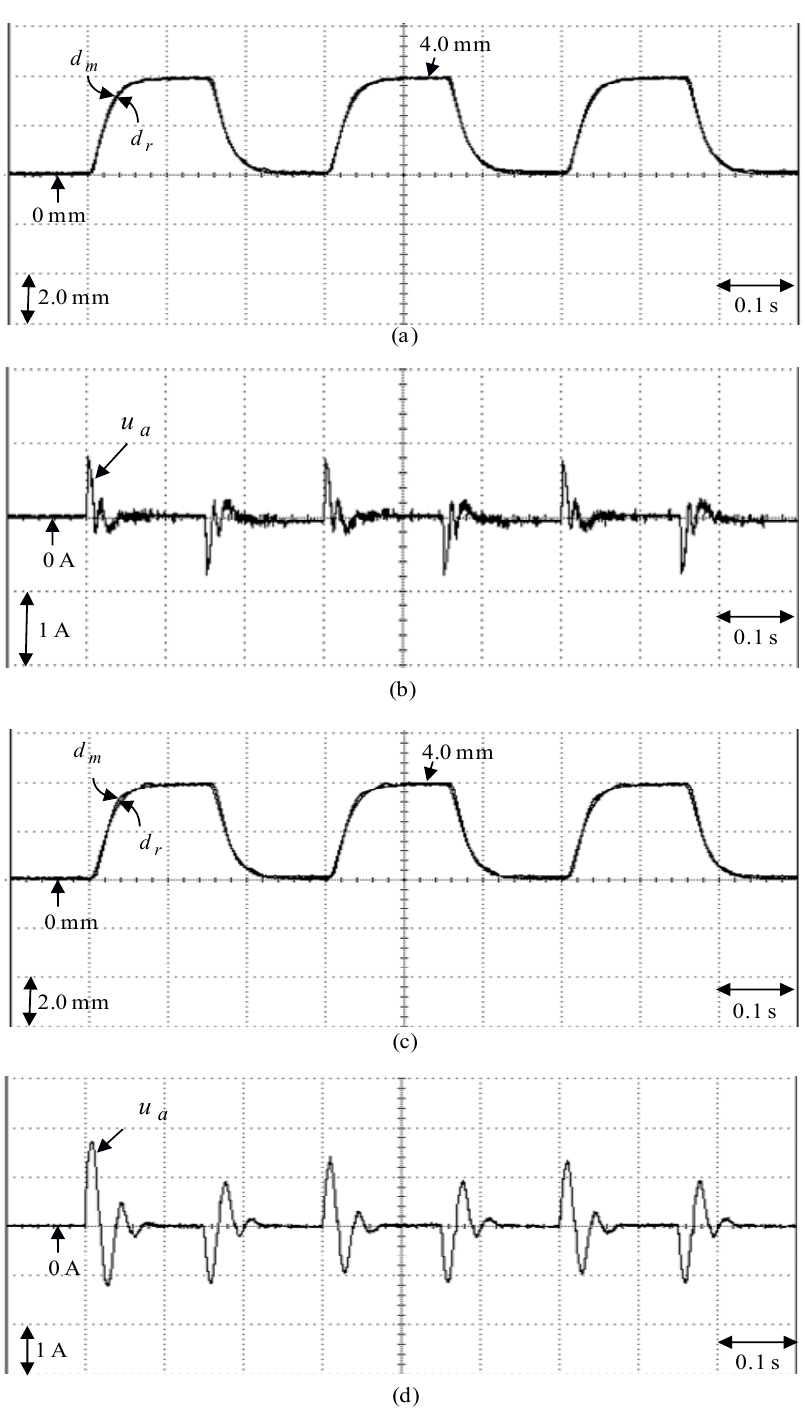
Figure 9. Experimental results of the eminent PI controller due to periodic step command from 0 mm to 4.0 mm: ( a ) position reaction of the mover in Case 1, ( b ) reaction of control effort in Case 1, ( c ) position reaction of the mover in Case 2, ( d ) reaction of control effort in Case 2.